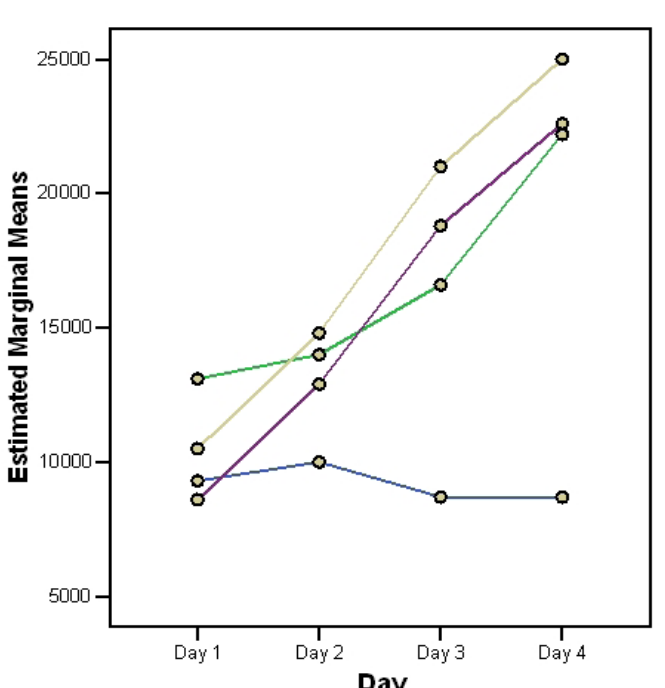
Fig. 5. Estimated marginal means of no of cells in media vs. day’s interaction